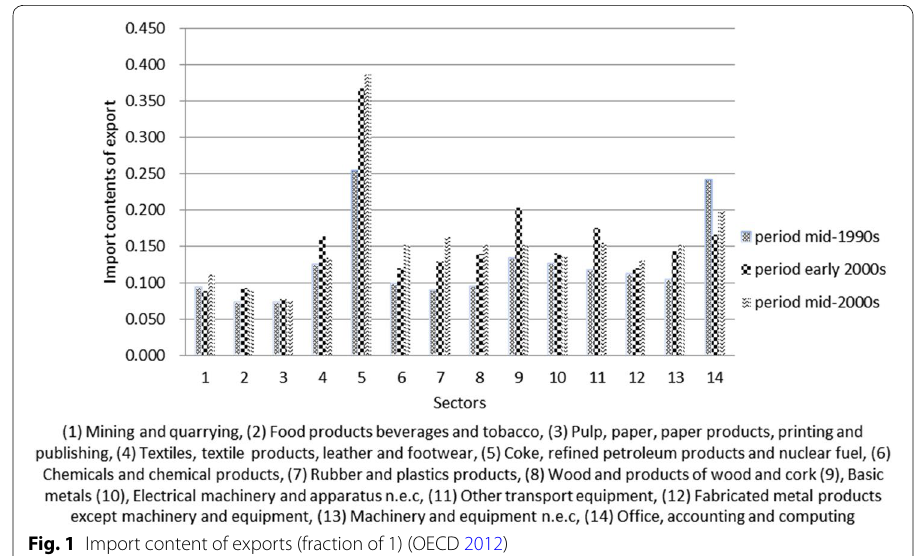
Fig. 1 Import content of exports (fraction of 1) (OECD